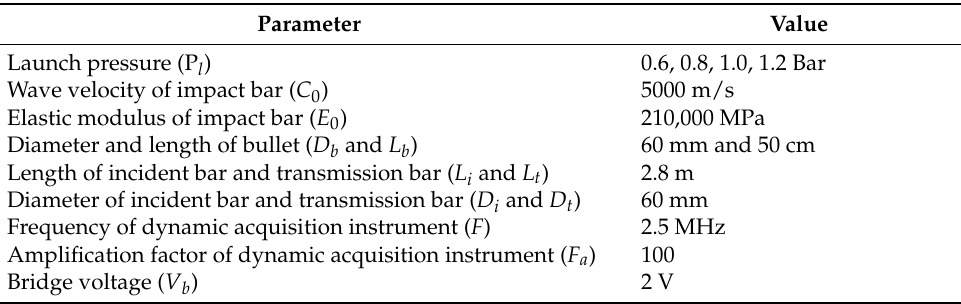
Figure 4. Diagram of the SHPB test system. Table 4. Specimen preparation scheme. Table 5. Parameters of SHPB